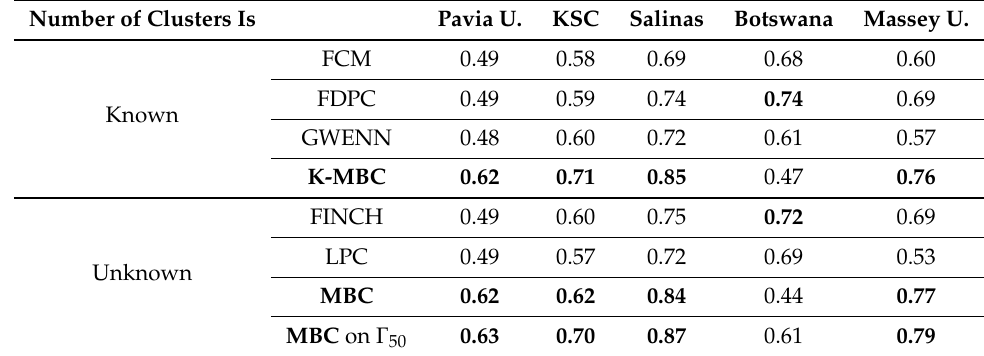
Table 6. Comparison of clustering results: Normalised Mutual Information (NMI) (higher is better, max: 1). Number of Clusters Is